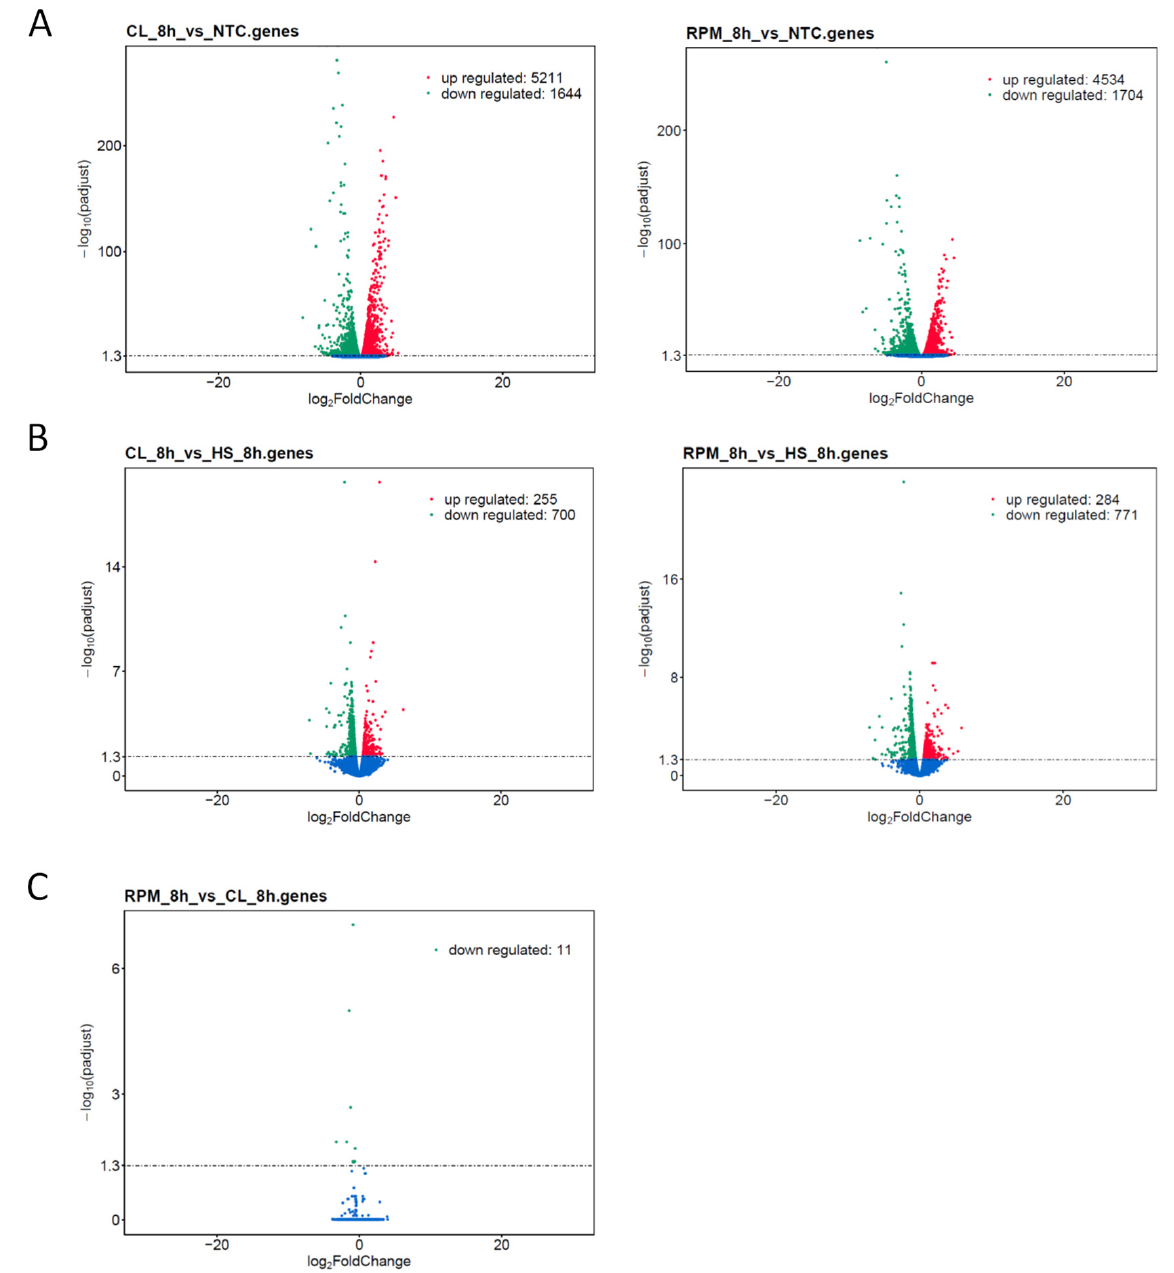
Figure 4. Volcano plots displaying overall distribution of differentially expressed genes in mouse T cells at 8 h of simulated microgravity . The x -axis shows the fold change in gene expression, and the y -axis designates the statistical significance of the differences between treatment group and control group with the threshold set as: padj < 0.05. Significantly up- and down-regulated genes highlighted in red and green, respectively, and other genes shown in blue. Treatment group versus control group data illustrated for comparisons: ( A ) Treatment by simulated microgravity in clinostat (CL) and random positioning machine (RPM) versus non-treated control (NTC). ( B ) Treatment by simulated microgravity in clinostat (CL) and random positioning machine (RPM) versus hydrodynamic stress (HS). ( C ) Treatment by simulated microgravity in random positioning machine (RPM) versus clinostat.